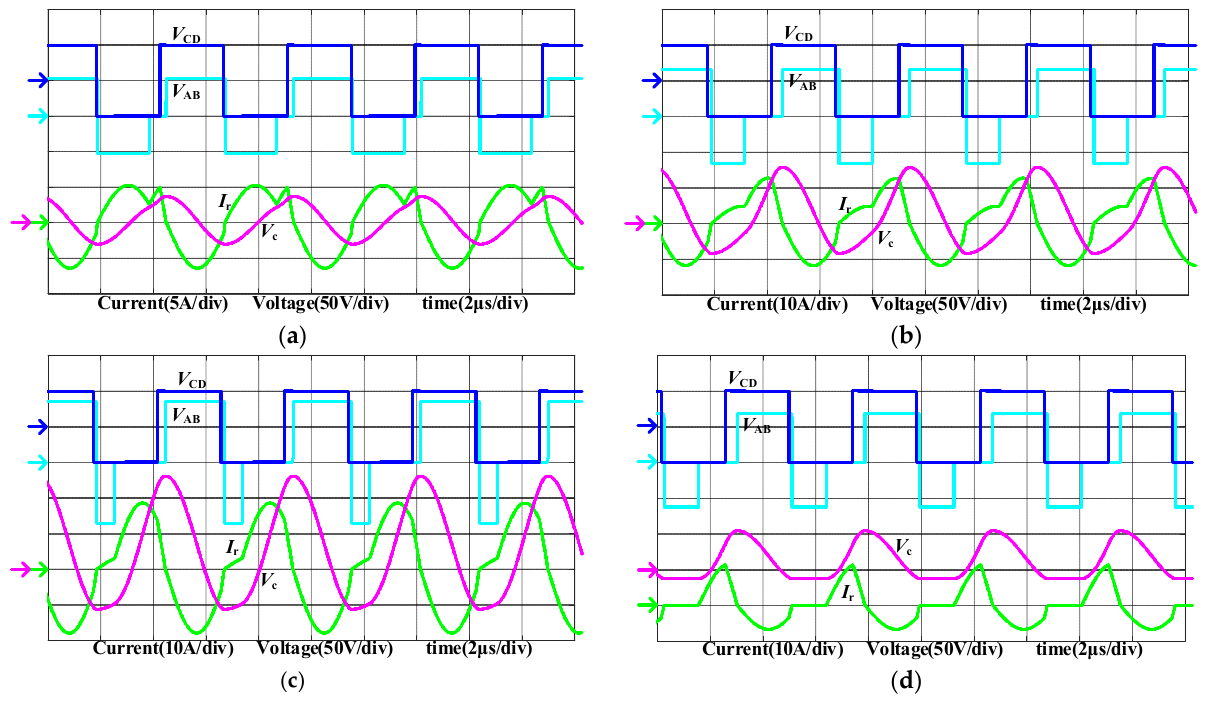
Figure 8. Simulation waveforms with different conditions. ( a ) d = 62.5% , ( b ) d = 75%, ( c ) d = 87.5% , ( d ) DCM.